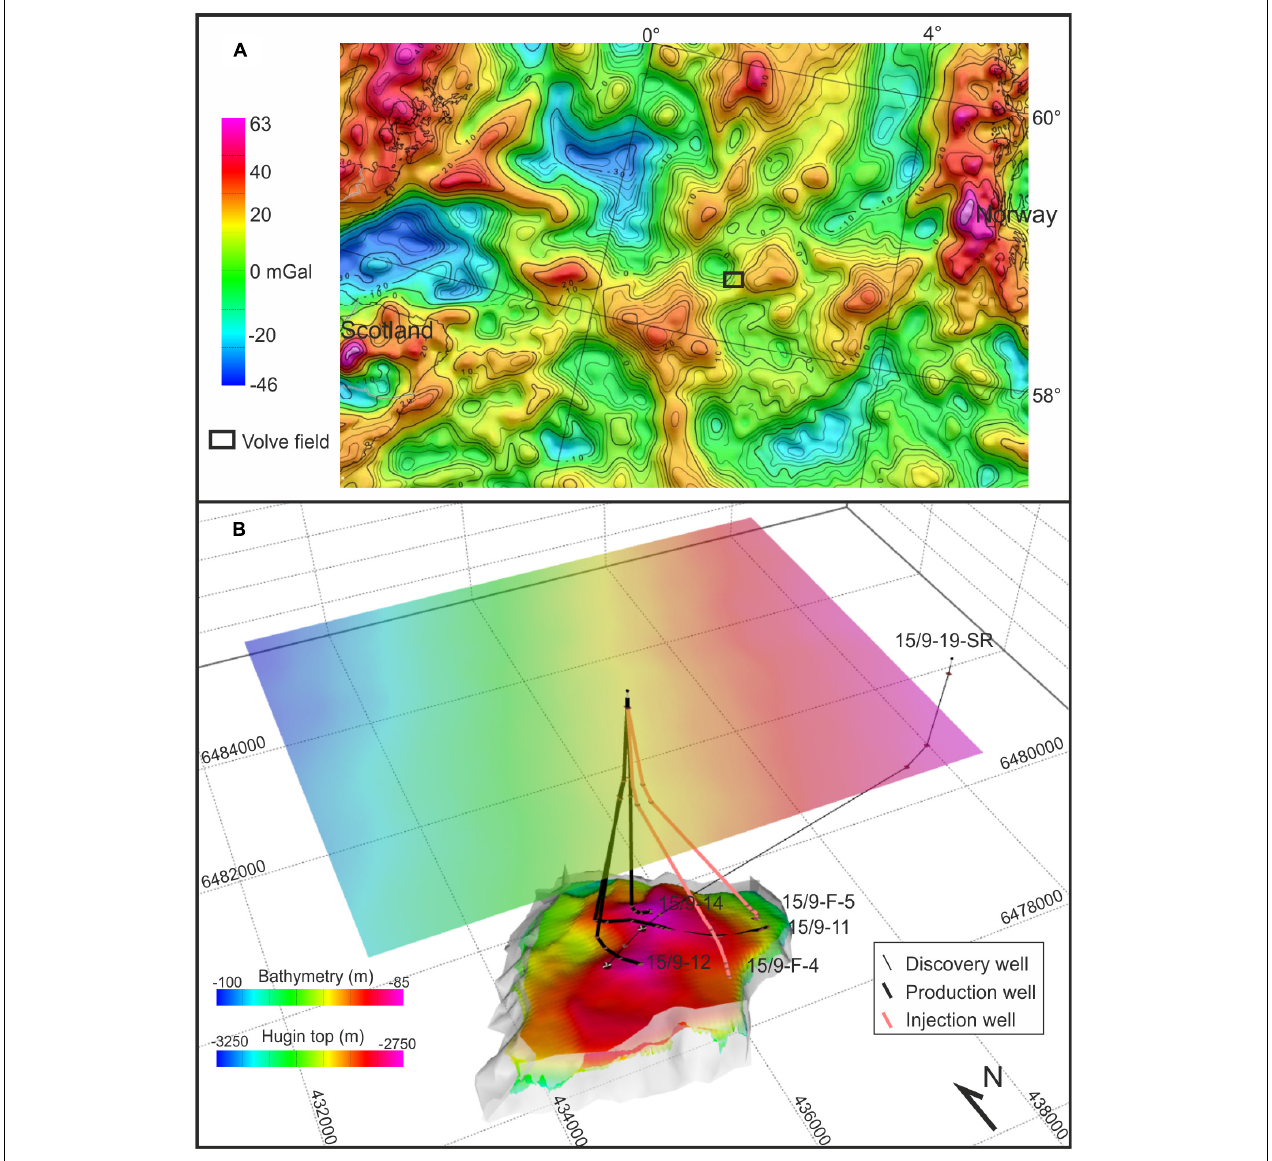
FIGURE 1 | (A) Free-air anomaly at sea and Bouguer anomaly on land over the study region (mod. from Olesen et al., 2010). (B) 3D model of the Volve field reservoir. Light gray surfaces represent bounding faults used to delimit Hugin top and bottom surfaces. Spacing between gray lines in the bounding box provides horizontal and vertical scales: spacing in the X–Y plane is 2 km while spacing in depth is 0.5 km. Coordinates are in ED50 UTM